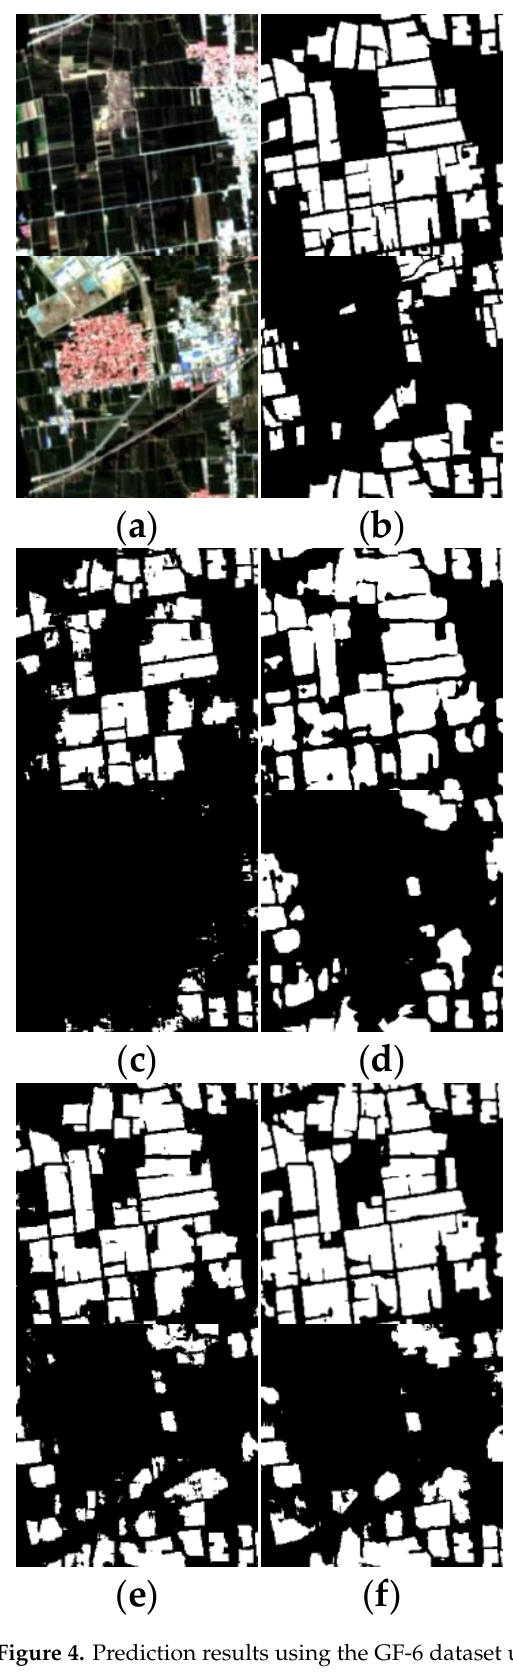
Figure 4. Prediction results using the GF-6 dataset used as training dataset: ( a ) Sentinel-2 original image, ( b ) label, ( c ) SegNet, ( d ) DeepLabV3+, ( e ) U-Net, ( f )